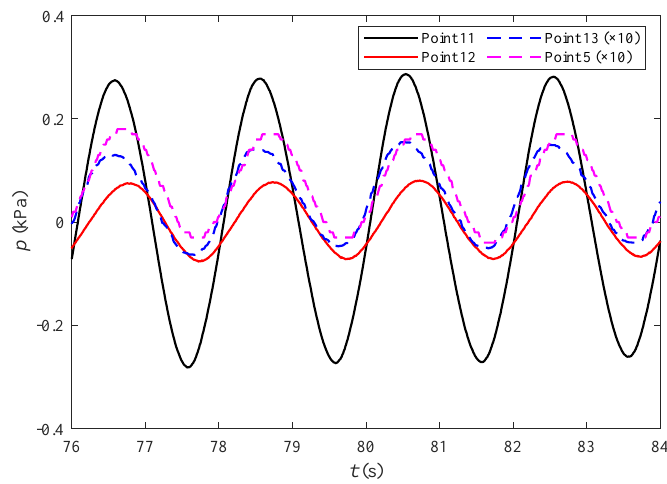
Figure 8. Distribution of pore-water pressures vs time in front of the pile in Test 43 ( x = 0.15 m, T = 2.0 s, H = 10 cm).